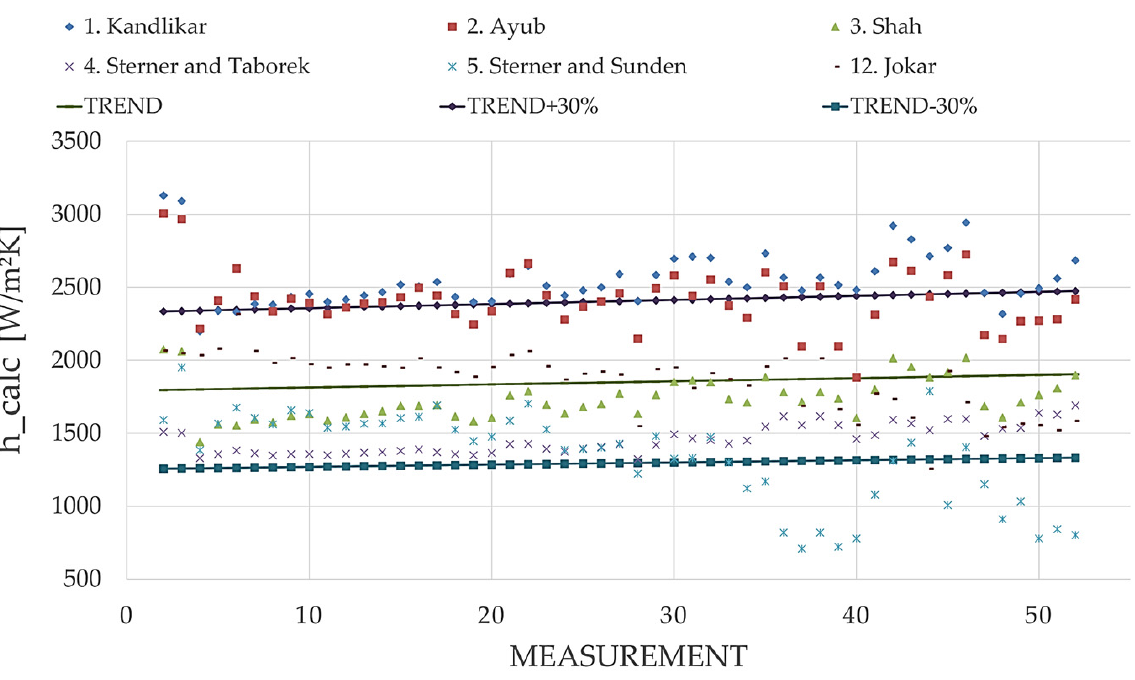
Figure 6. Calculated ammonia boiling coefficients related to trendlines of experimental values.